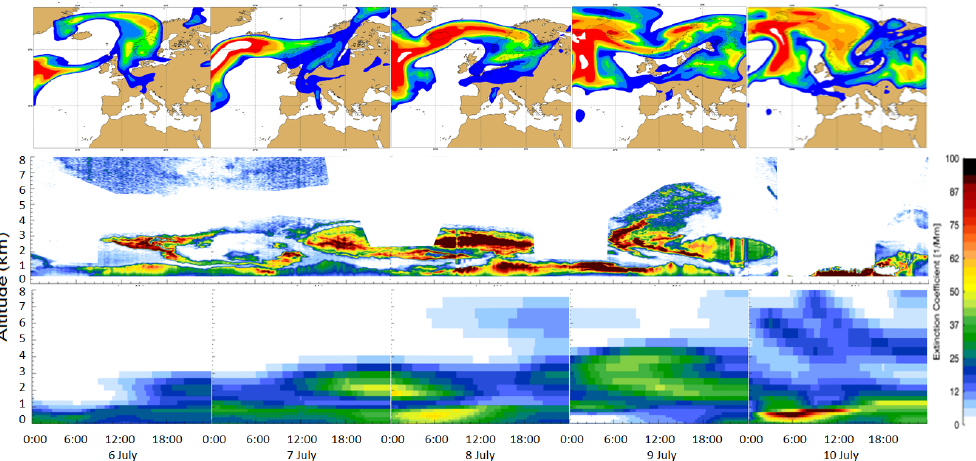
Figure 3. Example from the ceilometer study. (Top) MACC o-suite biomass-burning AOD over Europe from 6 to 9 July 2013 at 12:00UTC. (Middle) time–height plot of extinction coefficient above Soltau from 6 to 9 July 2013 from ceilometer. (Bottom) vertical profiles from the operational MACC o-suite at Soltau.